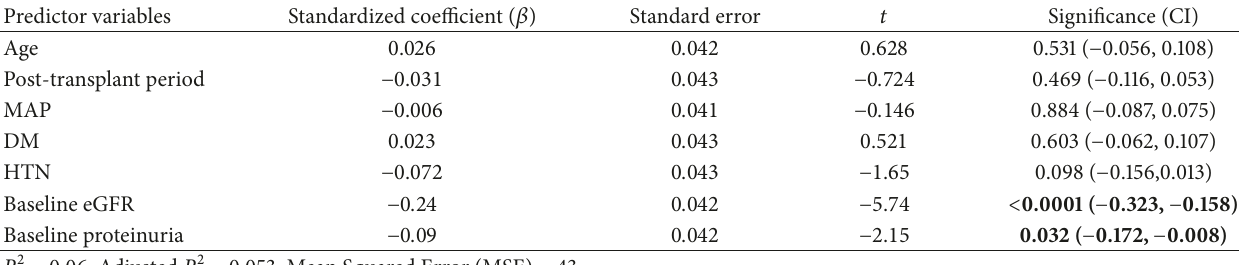
Table 4: Multivariate linear regression model of selected predictor variables and change in renal function (change in eGFR).